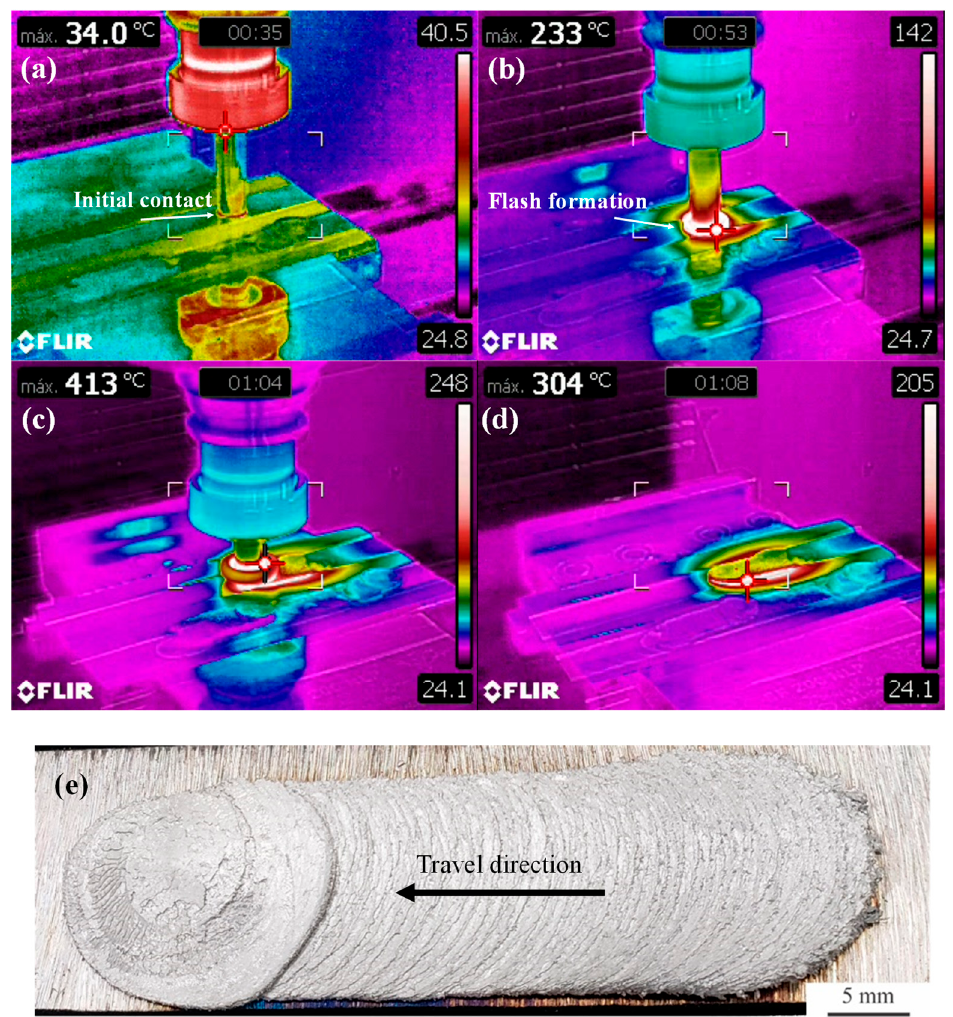
Figure 2. Analysis of the deposition process and final coating: ( a ) initial contact between consumable rod and substrate sheet, ( b ) flash formation at the consumable rod tip, ( c ) deposition, ( d ) retraction of the consumable rod and cooling and ( e ) top view of the as-deposited AA6351 coating obtained after friction surfacing on a AISI 1020 low carbon steel